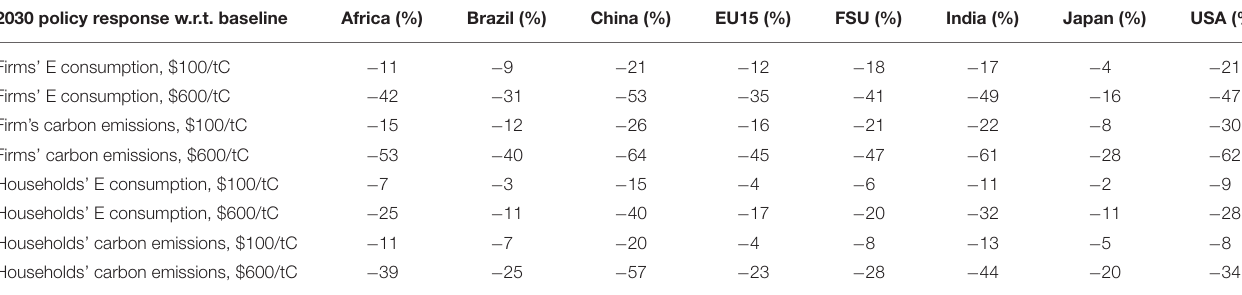
TABLE 2 | Response to carbon pricing of 8 economies in 2030 according to the POLES model. 2030 policy response w.r.t.